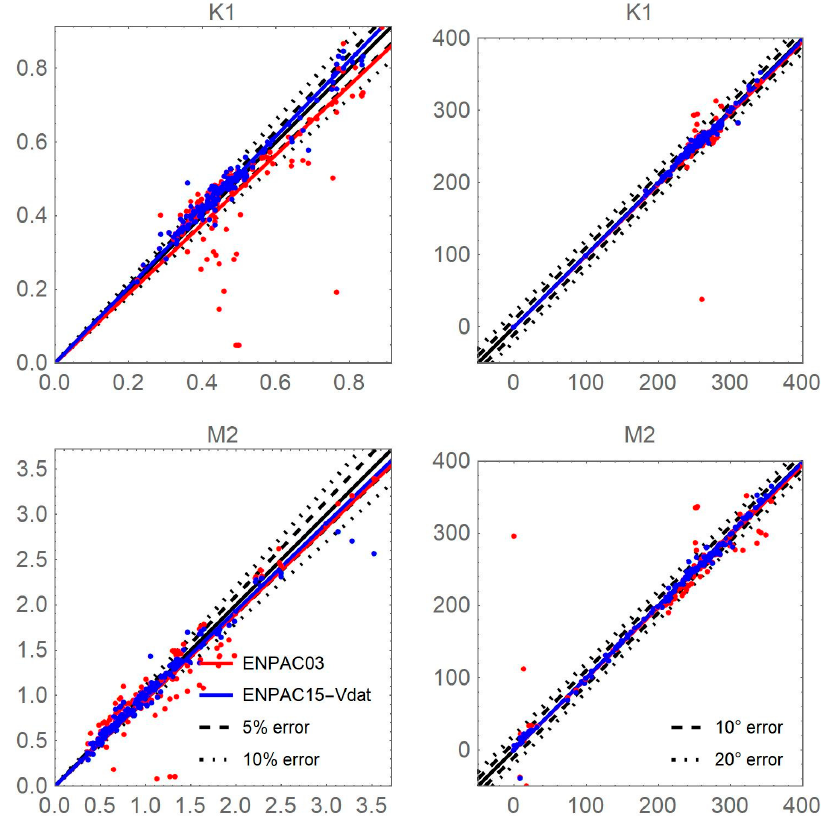
Figure 8. Comparison of scatter plots for the dominant constituents (K 1 , M 2 ) for the ENPAC03 and ENPAC15 tidal databases using the 165 common validation data stations.